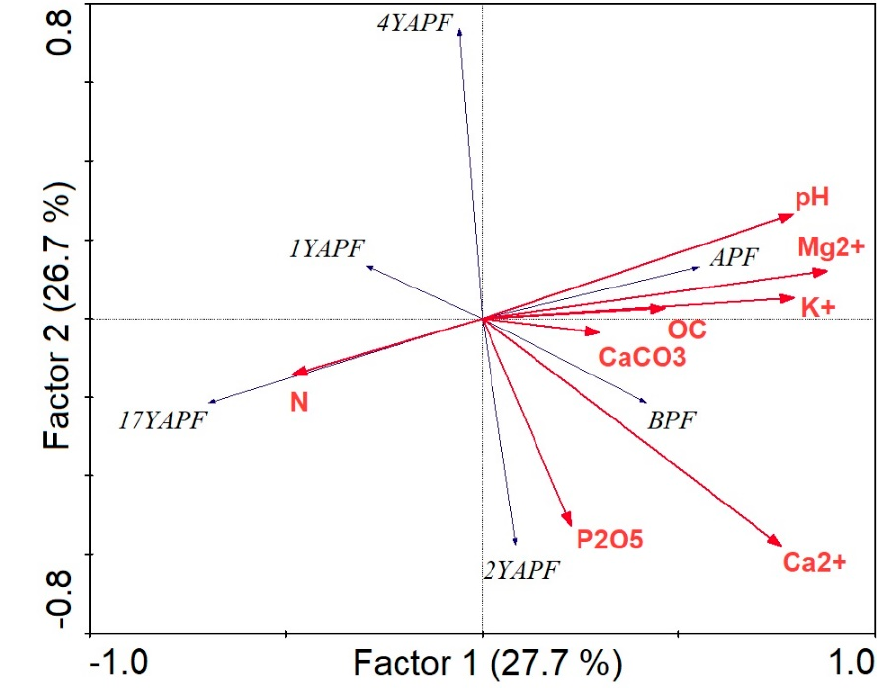
Figure 2. Redundancy analysis (RDA) showing the relation between factors 1 and 2. pH, organic carbon (OC), nitrogen (N), Ca 2+ , Mg 2+ , K + , P 2 O 5 and CaCO 3 . Before the prescribed fire (BPF), after the prescribed fire (APF), one year after the prescribed fire (1YAPF), two years after the prescribed fire (2YAPF), four years after the prescribed fire (4YAPF), and 17 years after the prescribed fire (17YAPF)